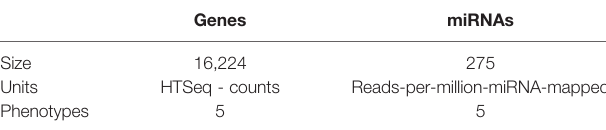
TABLE 2 | Summary of genes and